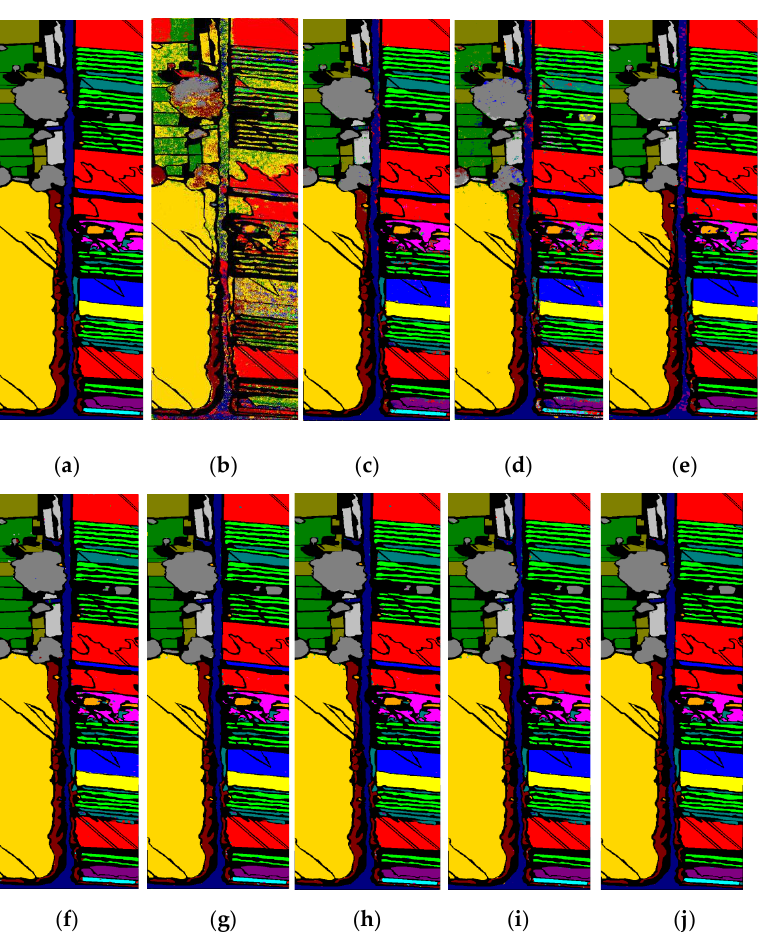
Figure 9. The classification results of HanChuan dataset. ( a ) Ground Truth; ( b ) RBF-SVM; ( c ) EMP- SVM; ( d ) CNN; ( e ) ResNet; ( f ) MLP-Mixer; ( g ) RepMLP; ( h ) DFFN; ( i ) DMLP; ( j ) DMLPFFN.